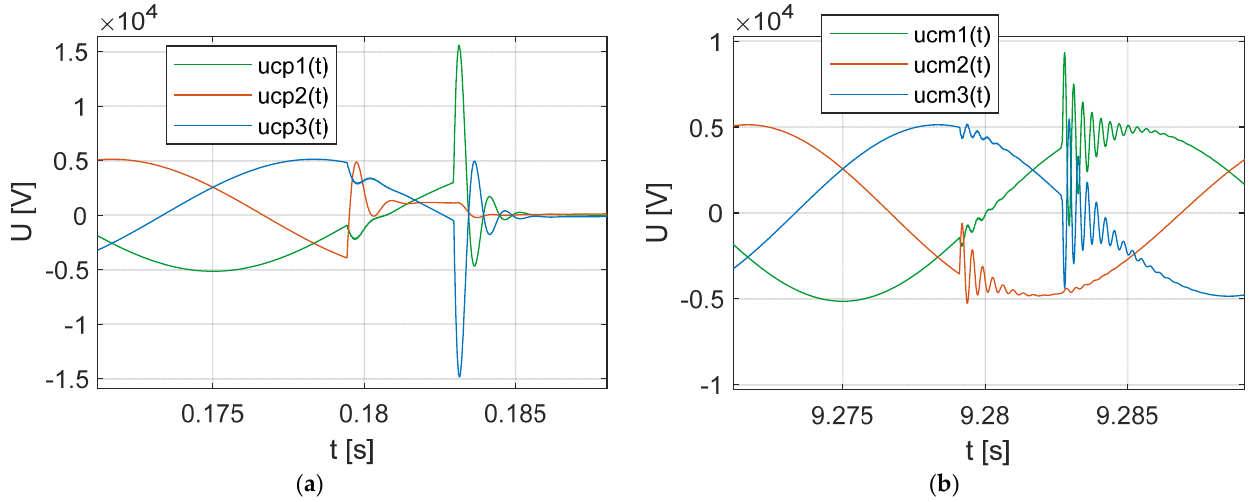
Figure 9. Simulation results ( a ) Load voltage (EMTP algorithm); ( b ) Load voltage (Clark transformation). Source: own calculations.